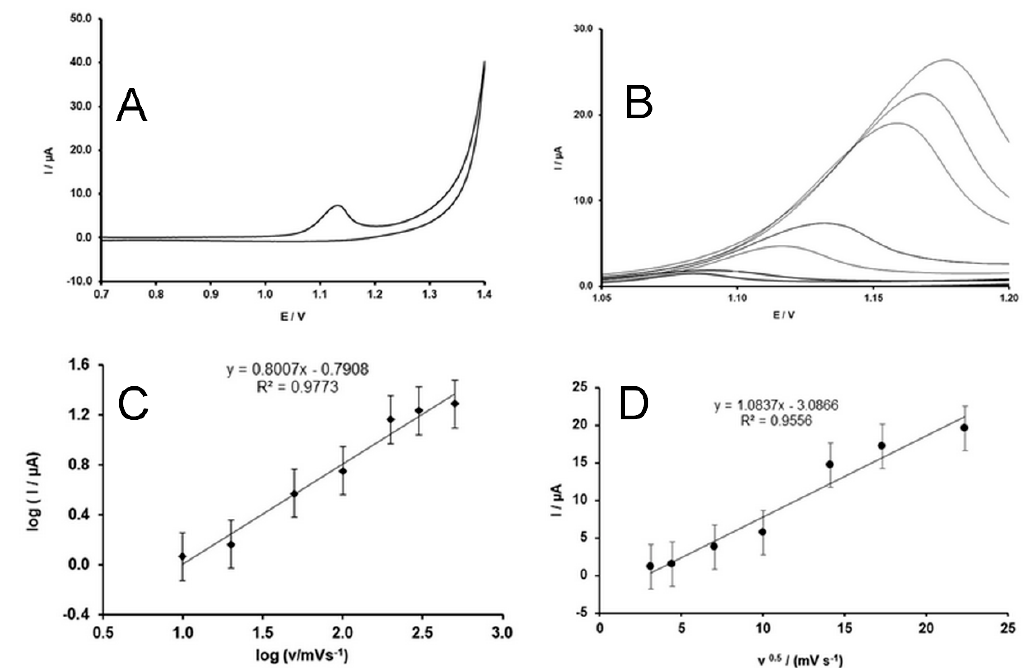
Figure 6. ( A ) CV of 5 × 10 − 4 M SIM in 0.1 M H 2 SO 4 at 100 mV ∙ s − 1 ; ( B ) the forward scan of CVs at various potential scan rates (10, 20, 50, 100, 200, 300, and 500 mV ∙ s − 1 ) (only a potential range related to the peak is shown to see the peaks well); ( C ) scan rate dependence of the oxidation peak current in logarithmic coordinates; ( D ) dependence of the oxidation peak current on the square root of the scan rate.